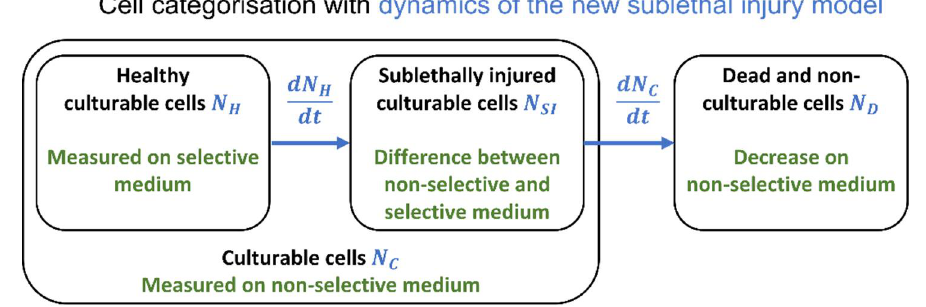
Figure 2. Overview of the microbial subpopulations that are considered in the sublethal injury model. All cells can be divided in culturable and dead cells. The culturable cells can be subdivided in healthy and injured cells. The mathematical notations and conversions are marked in blue and the experimental quantifications are written in green.